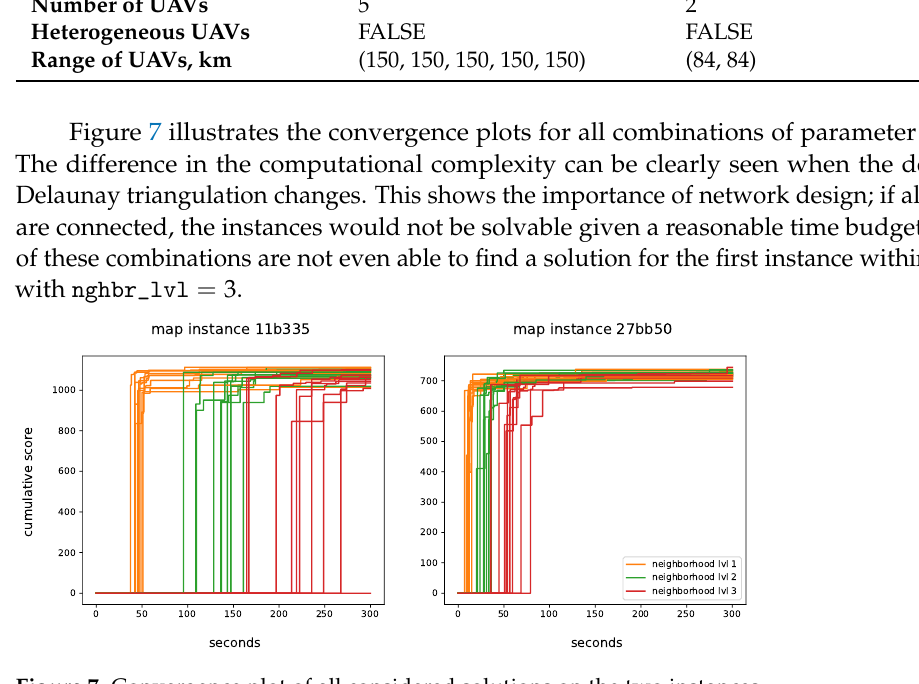
Figure 7. Convergence plot of all considered solutions on the two